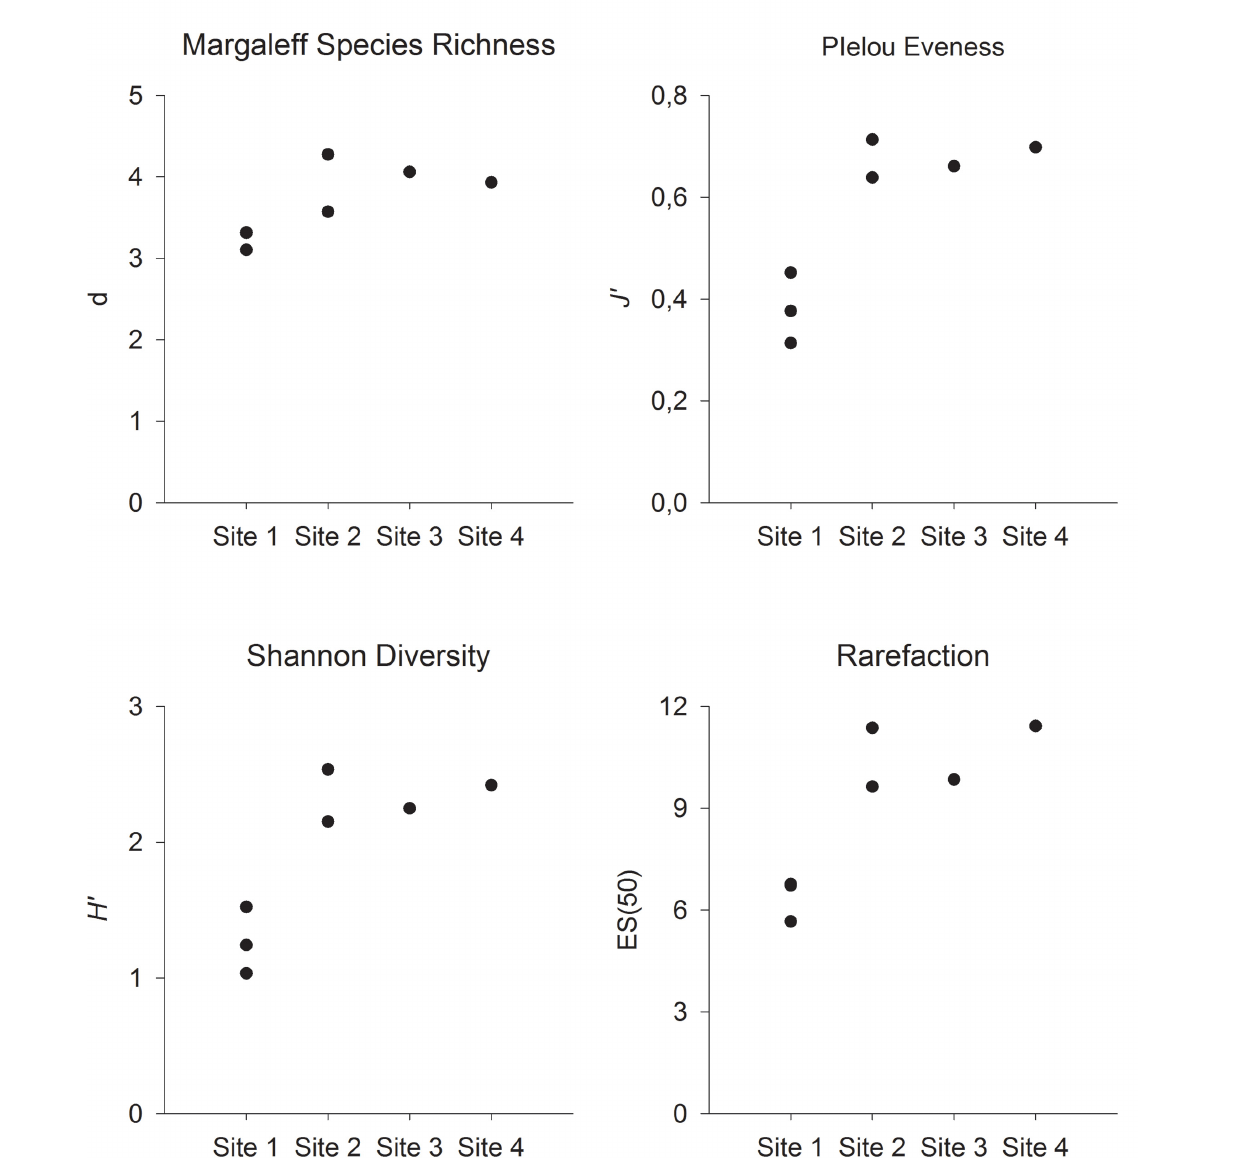
FIGURE 6 | Margalef’s species richness (d), Pielou’s evenness ( J’ ), Shannon biodiversity ( H’ ), and estimated number of species (ES50) at the four sites on Mohn’s Treasure. Site 1: VT6, 7, and 8. Site 2: VT8 and 9. Site 3: VT5. Site 4: